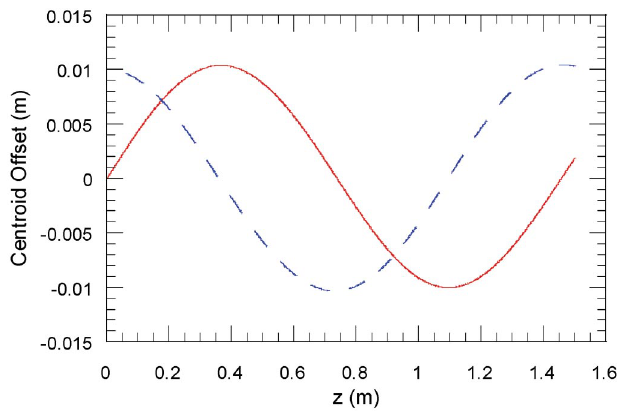
FIG. 6. (Color) Ion centroid motion in the electron beam’s potential well. The red line is the horizontal offset and the blue line is the vertical offset.